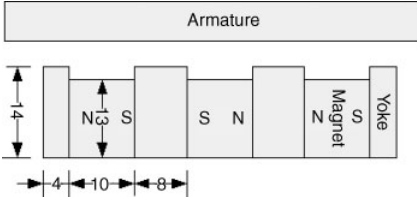
Figure 5 Type A structure of the magnetic unit.